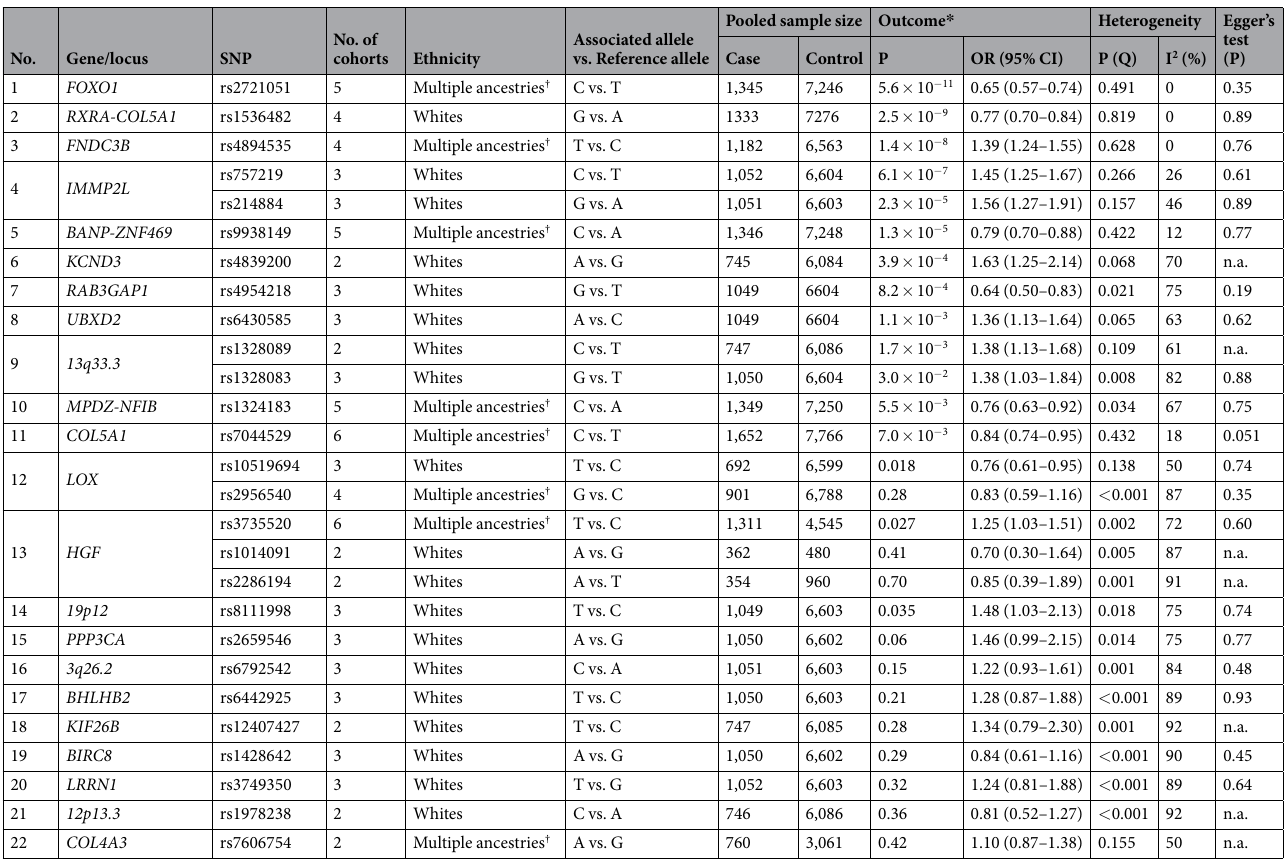
Table 2. Allelic associations of gene variations with keratoconus using cohorts from both GWAS and subsequent replication studies. * A random-effects model was used. † Multiple ancestries included 2 or more ethnic groups from Whites and Asian (Arabic, Chinese, Korean, Japanese, or Indian). CI = confidence interval; OR = odds ration; SNP = single nucleotide polymorphism; n.a. = not applicable; No. =